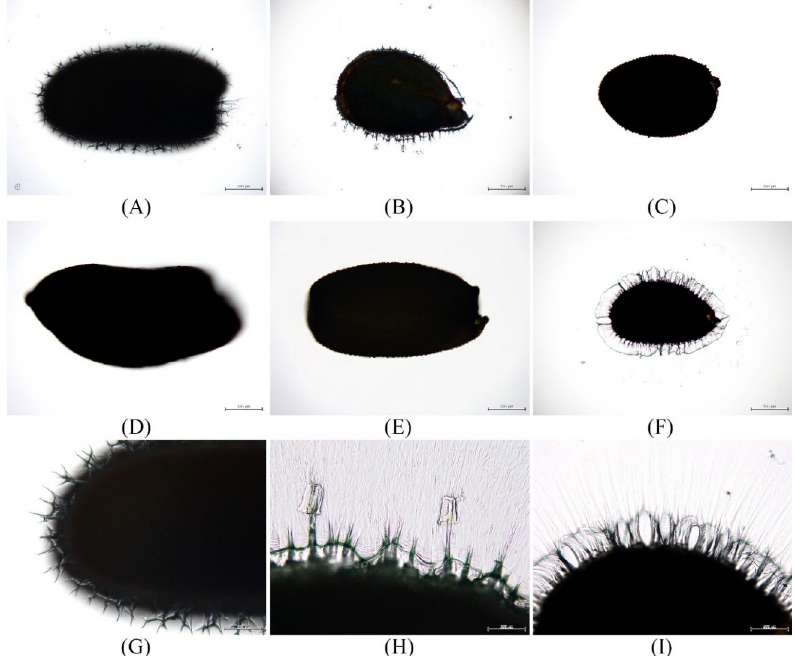
Figure 4. Light microscope micrographs showing release of mucilage from seeds upon hydration. ( A , G ) Descurainia sophia ; weak mucilage reaction. ( B , H ) Lepidium apetalum ; moderate mucilage reaction. ( C ) Draba nemorosa ; no mucilage reaction. ( D ) Erysimum cheiranthoides ; no mucilage reaction. ( E ) Erysimum macilentum ; no mucilage reaction. ( F , I ) Lepidium virginicum ; moderate mucilage reaction.